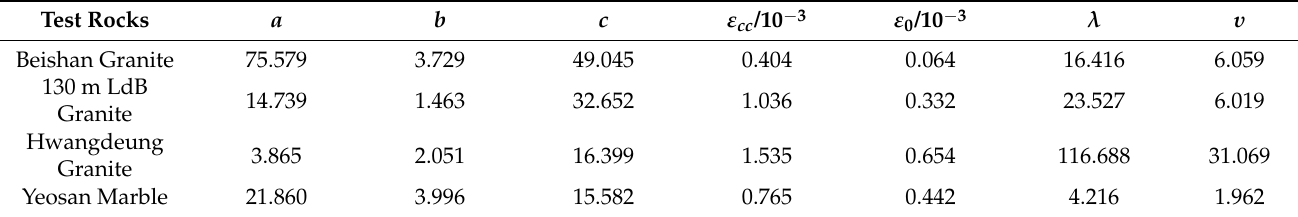
Table 1. Model parameters for uniaxial